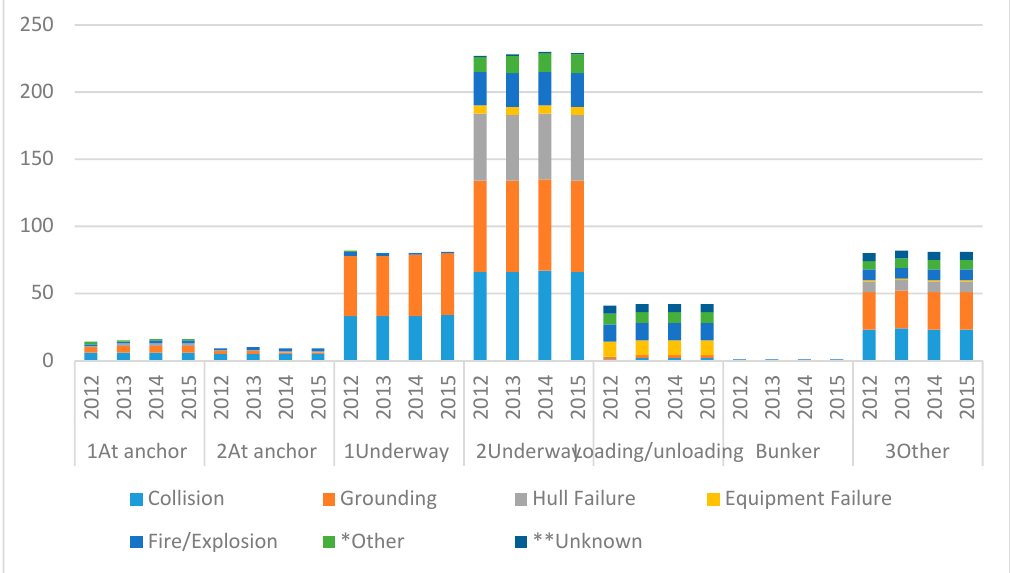
Table 9. Statistics for oil spills over 700 tons from 2012 to 2015.